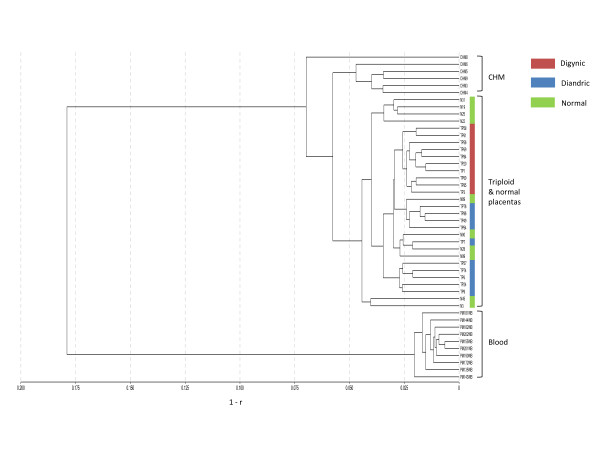
Unsupervised clustering of triploid and normal placentas with CHMs and blood samples demonstrates that each tissue type has a distinct methylation profile. Sample names are shown with labelling of corresponding tissue types. Samples were clustered by hierarchical clustering of β values based on 1-r (Illumina GenomeStudio software), where r represents the correlation coefficient between samples. Digynic triploids are indicated by red boxes, diandric triploids by blue boxes and normal placentas by green boxes.